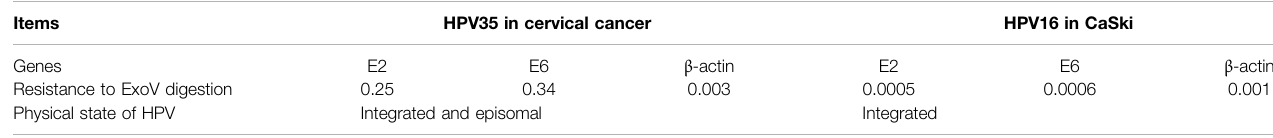
TABLE 2 | Physical state determination of the HPV genome by exonuclease V (ExoV)-qPCR – based assay.